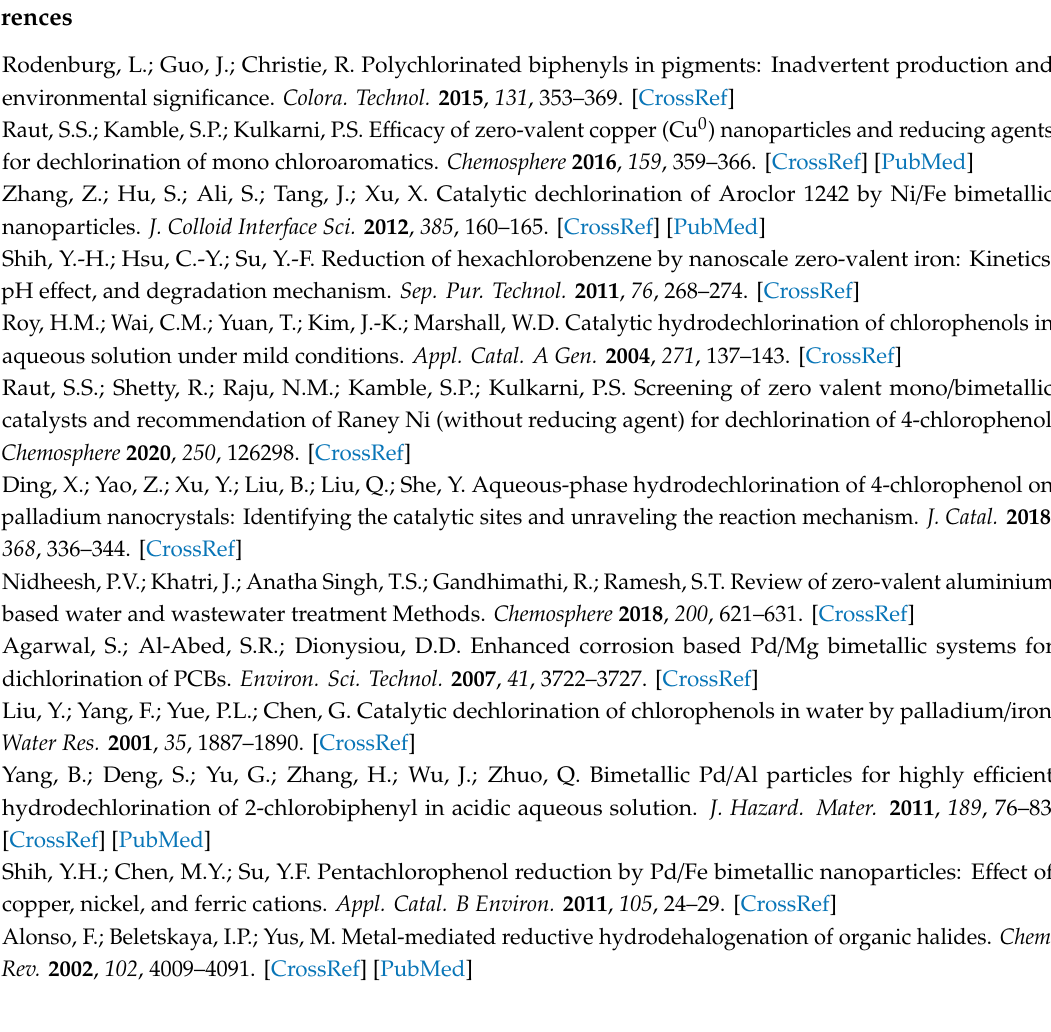
Table S1: Composition of the reaction mixtures obtained by overnight action of 1.5 g the Dev. alloy and 2 g NaOH in 200 mL of aqueous (or 1:1 CH 3 OH:H 2 O) solution.; Table S2: Composition of the reaction mixtures obtained by overnight action of 5 mmol NaBH 4 and eventually 2 mmol of CuSO 4 or NiSO 4 on 50 µ mol of corresponding chlorinated benzene in 200 mL solution of CH 3 OH:H 2 O = 1:1.; Table S3: Composition of the reaction mixtures obtained by overnight action of 5 mmol NaBH 4 and eventually 2 mmol of CuSO 4 or NiSO 4 on 0.1 mmol of chlorobenzene (CB) in 200 mL aqueous solution.; Figure S1. SEM images of Devarda’s Al-Cu-Zn used in HDC magnification. Figure S3. Time dependences for HDC of Cl-ANs using the Raney Al-Ni alloy with and without addition of glucose. Figure S4. Time dependences for HDC of triCBs using the Raney Al-Ni alloy. Figure S5. Time dependences for HDC of DCBs using the Raney Al-Ni alloy. Figure S6. GC / MS analysis of DCM extract of sample 811OVVUOS (technological water produced at the azo pigments production site)—upper trace and sample 1112TW (after HDC treatment)—bottom trace and MS